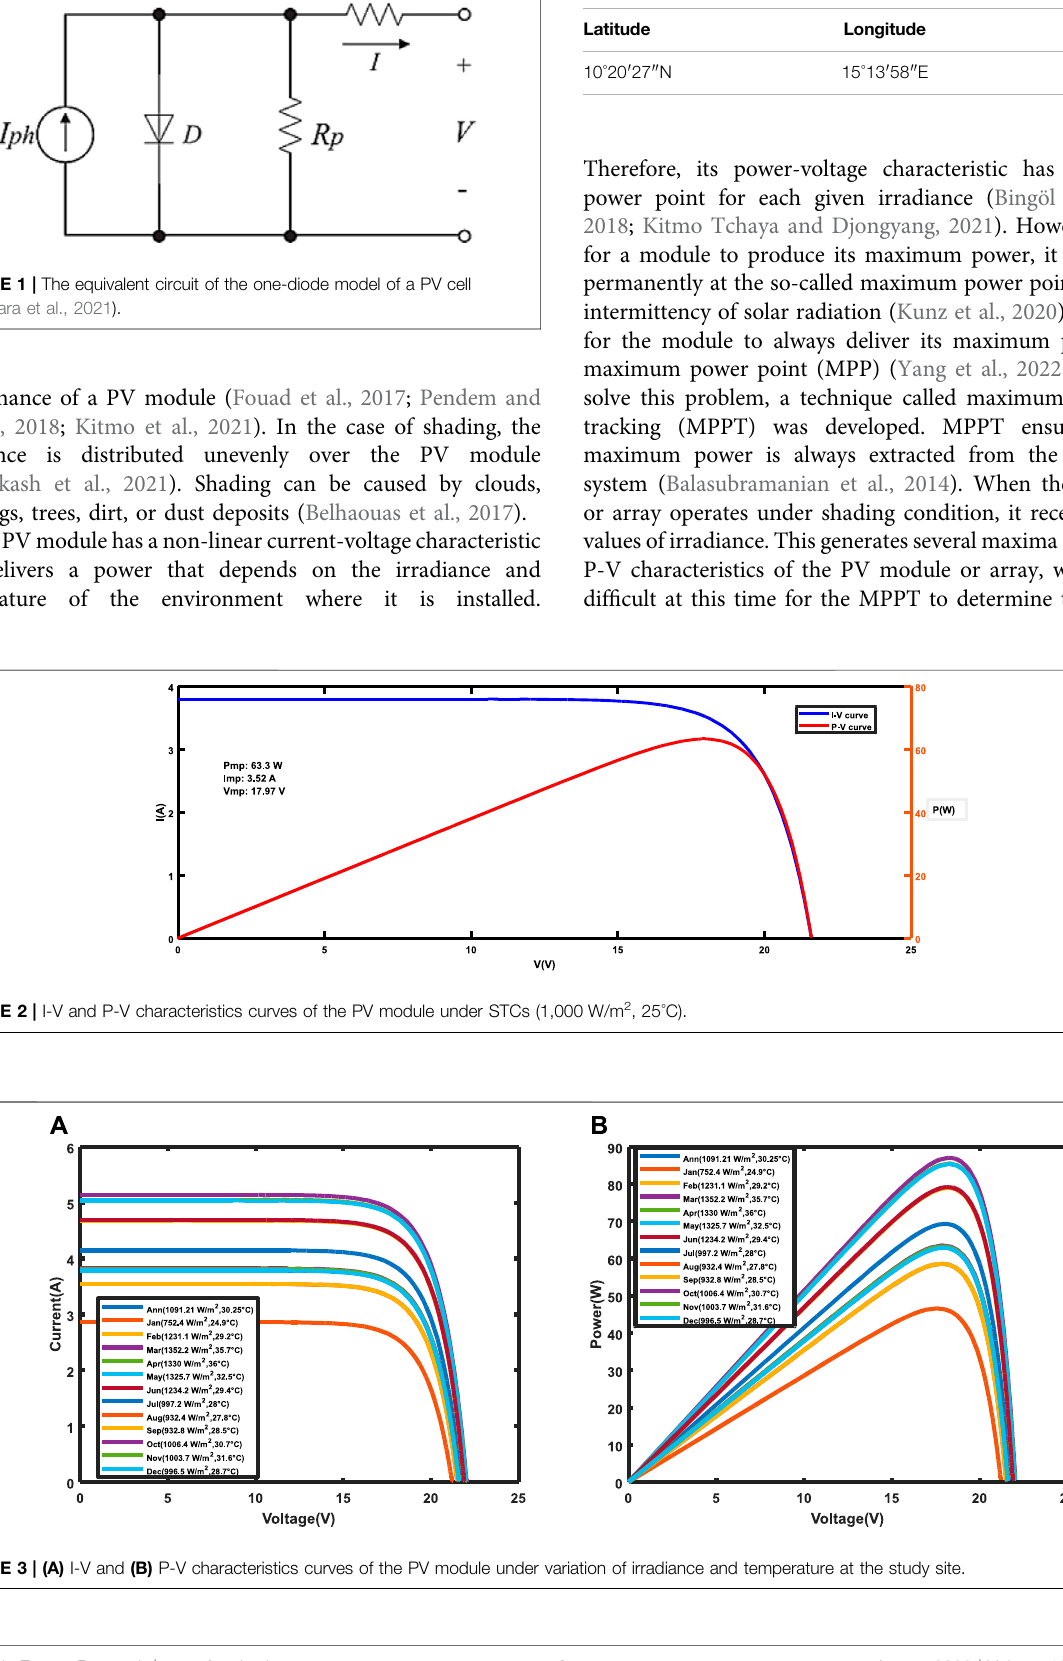
Frontiers in Energy Research |